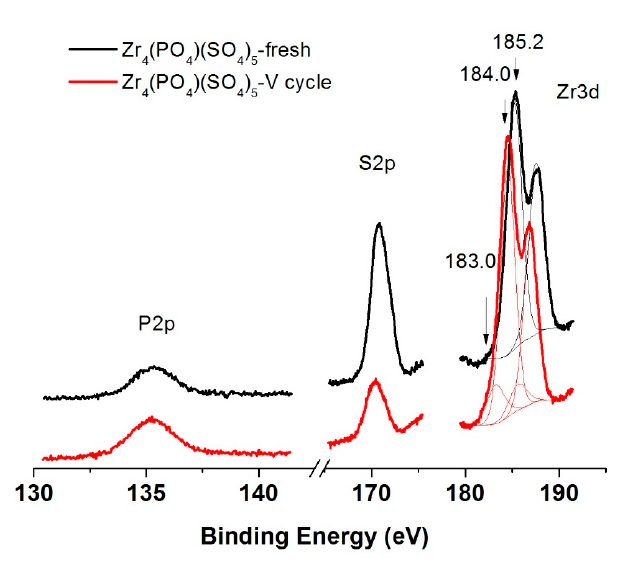
Figure 6. P2p, S2p and Zr3d XPS region of Zr 4 (PO 4 ) 2 (SO 4 ) 5 fresh and after five catalytic cycles.